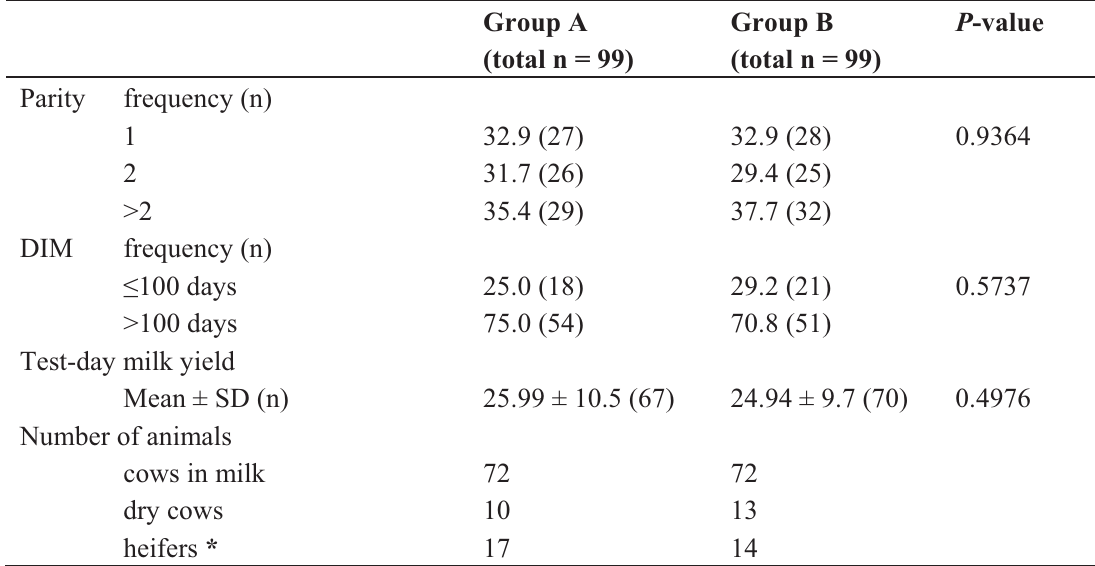
Table 2. Summary statistics: Composition of groups (parity, days in milk (DIM), test-day milk yield) at the start of the